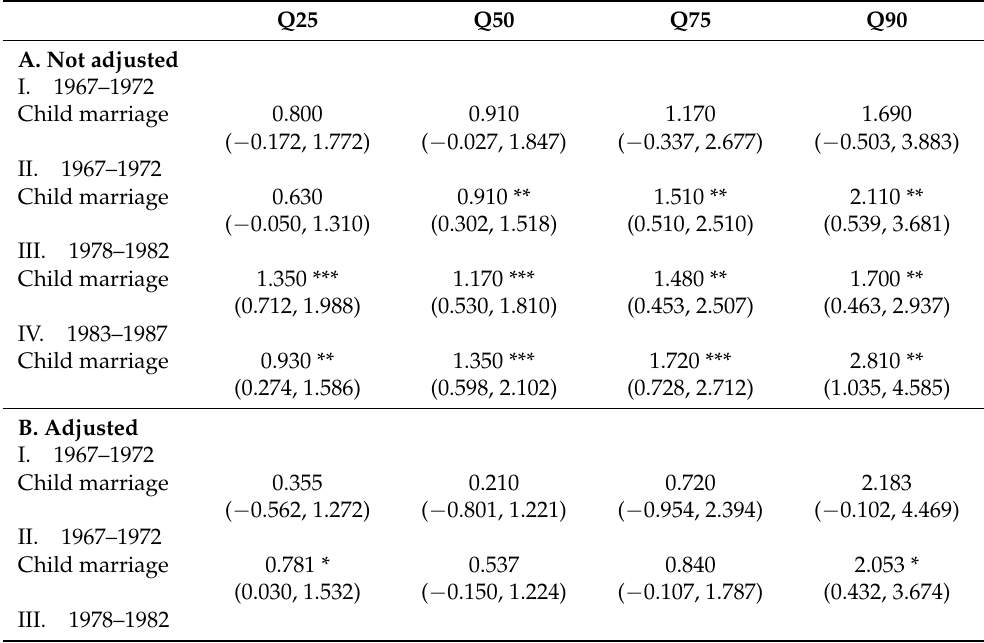
Table 9. Quantile regression results for body mass index by birth